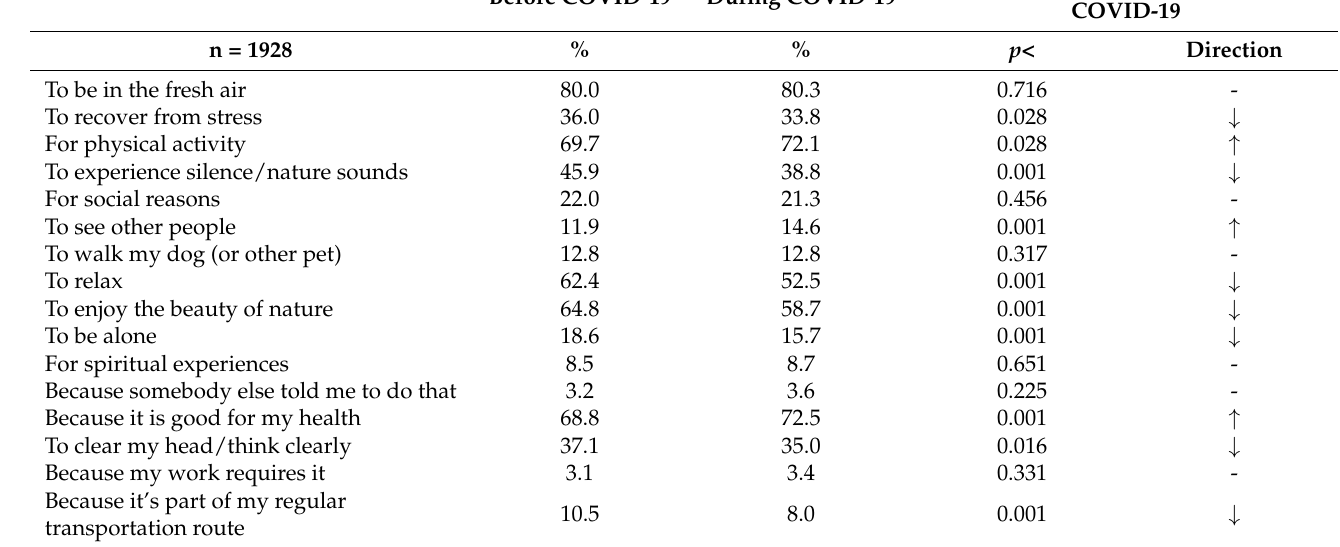
Table 4. The proportion of individuals responding with “often” or “very often” to an alterna- tive of the question: “What kind of natural areas did you visit before and resp. during the COVID-19 pandemic?”.